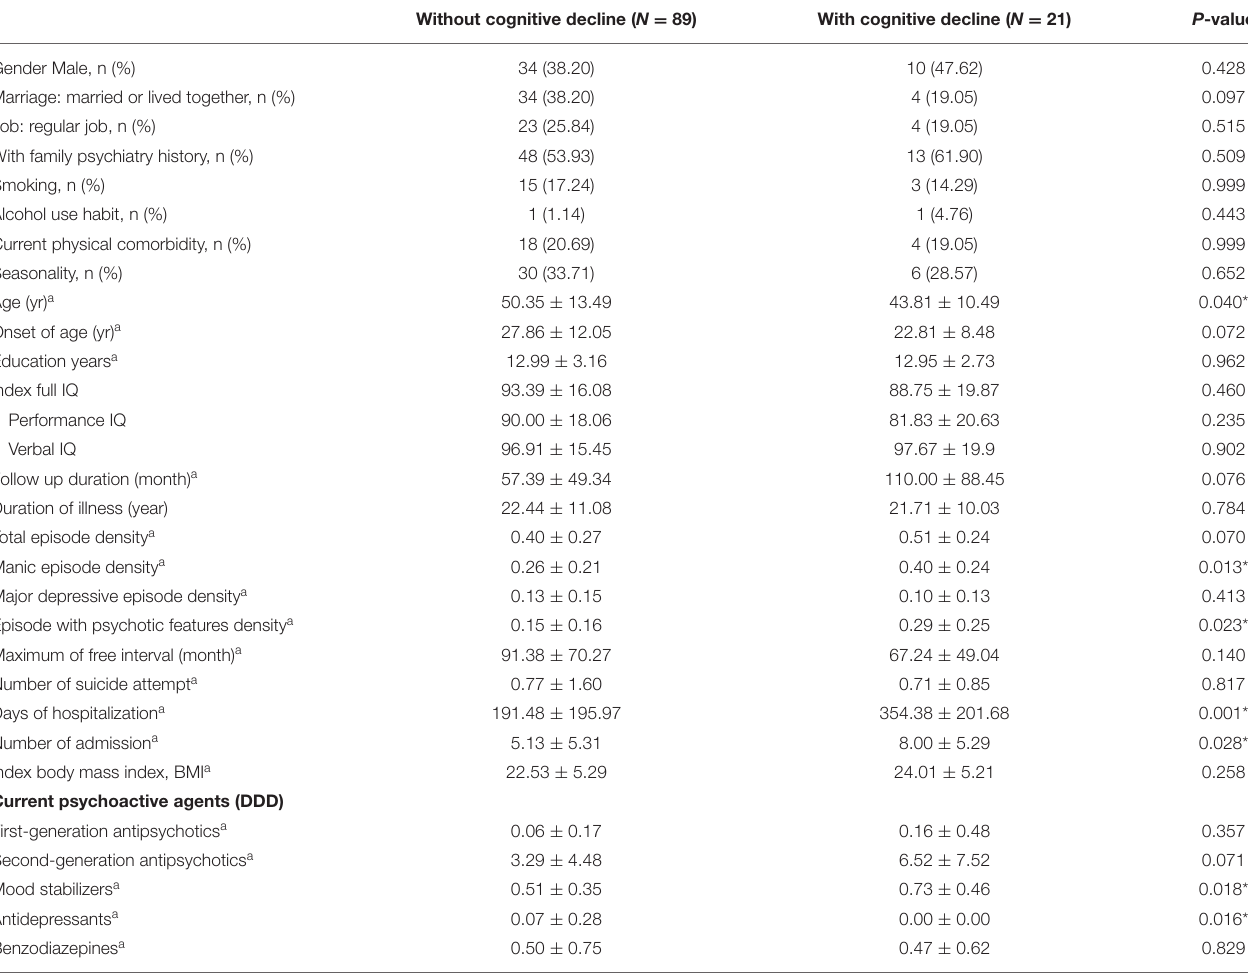
TABLE 1 | Sociodemographic and clinical characteristics of BD patients with and without cognitive decline. Without cognitive decline ( N = 89) With cognitive decline ( N = 21) P -value 34